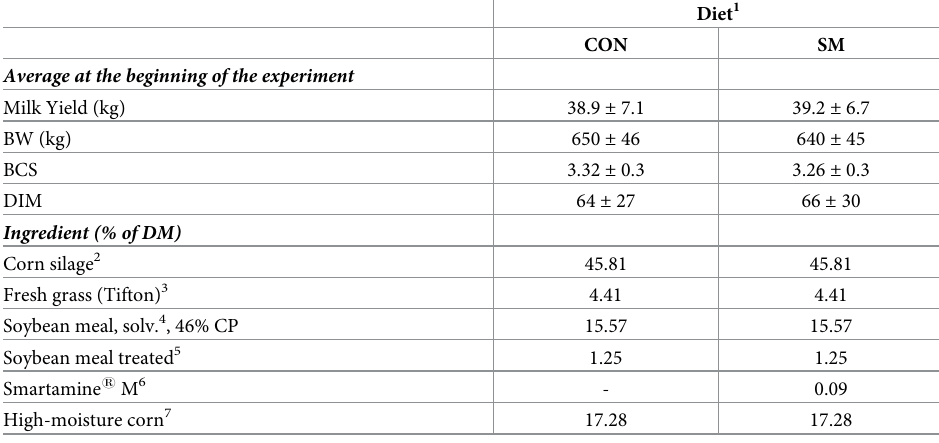
Table 1. Ingredient and nutritional composition of treatments